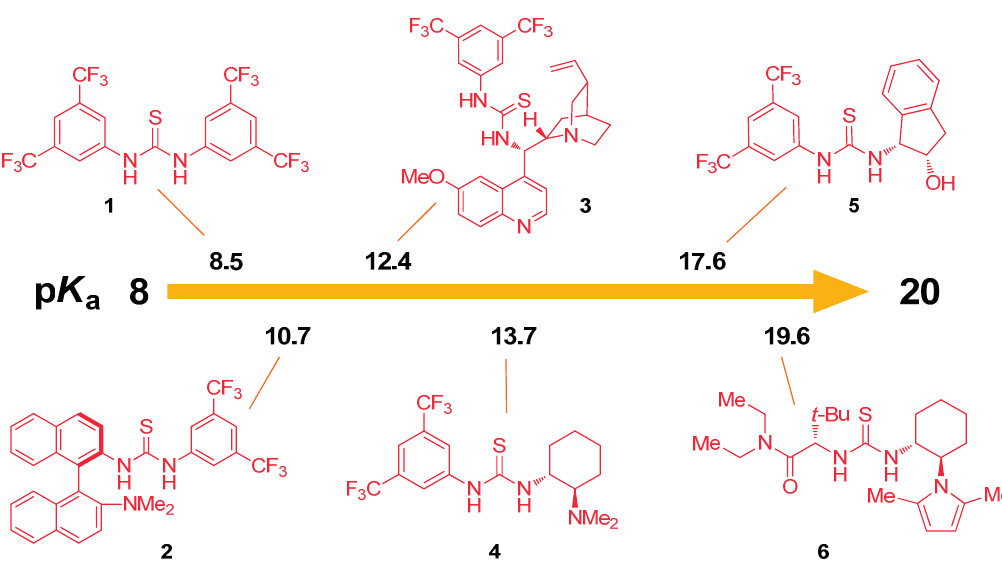
Figure 1. Equilibrium acidities of various thioureas in DMSO.